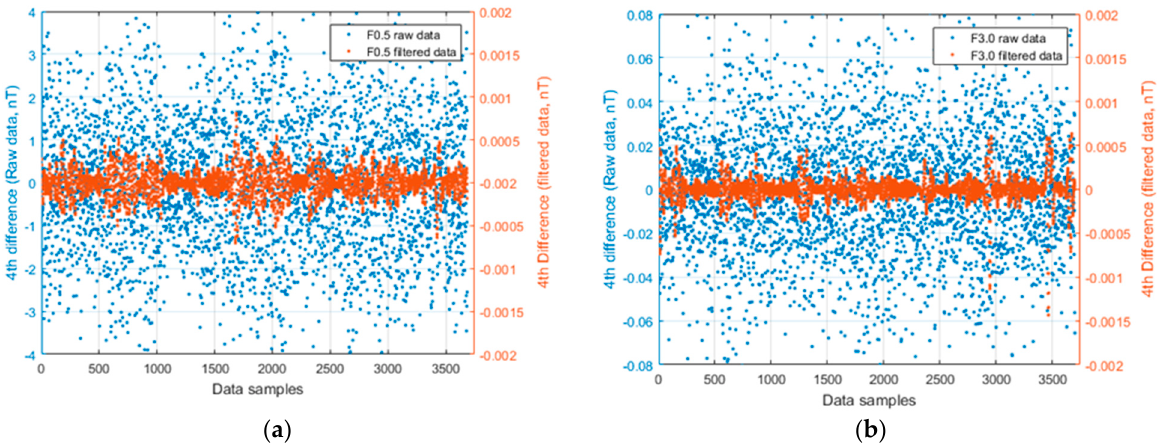
Figure 7. The calculated fourth difference of F0.5 ( a ) and F3.0 ( b ) datasets. Blue points refer to the raw data (amplitudes on the left y -axis), and red points refer to the filtered data (amplitudes on the right y -axis).